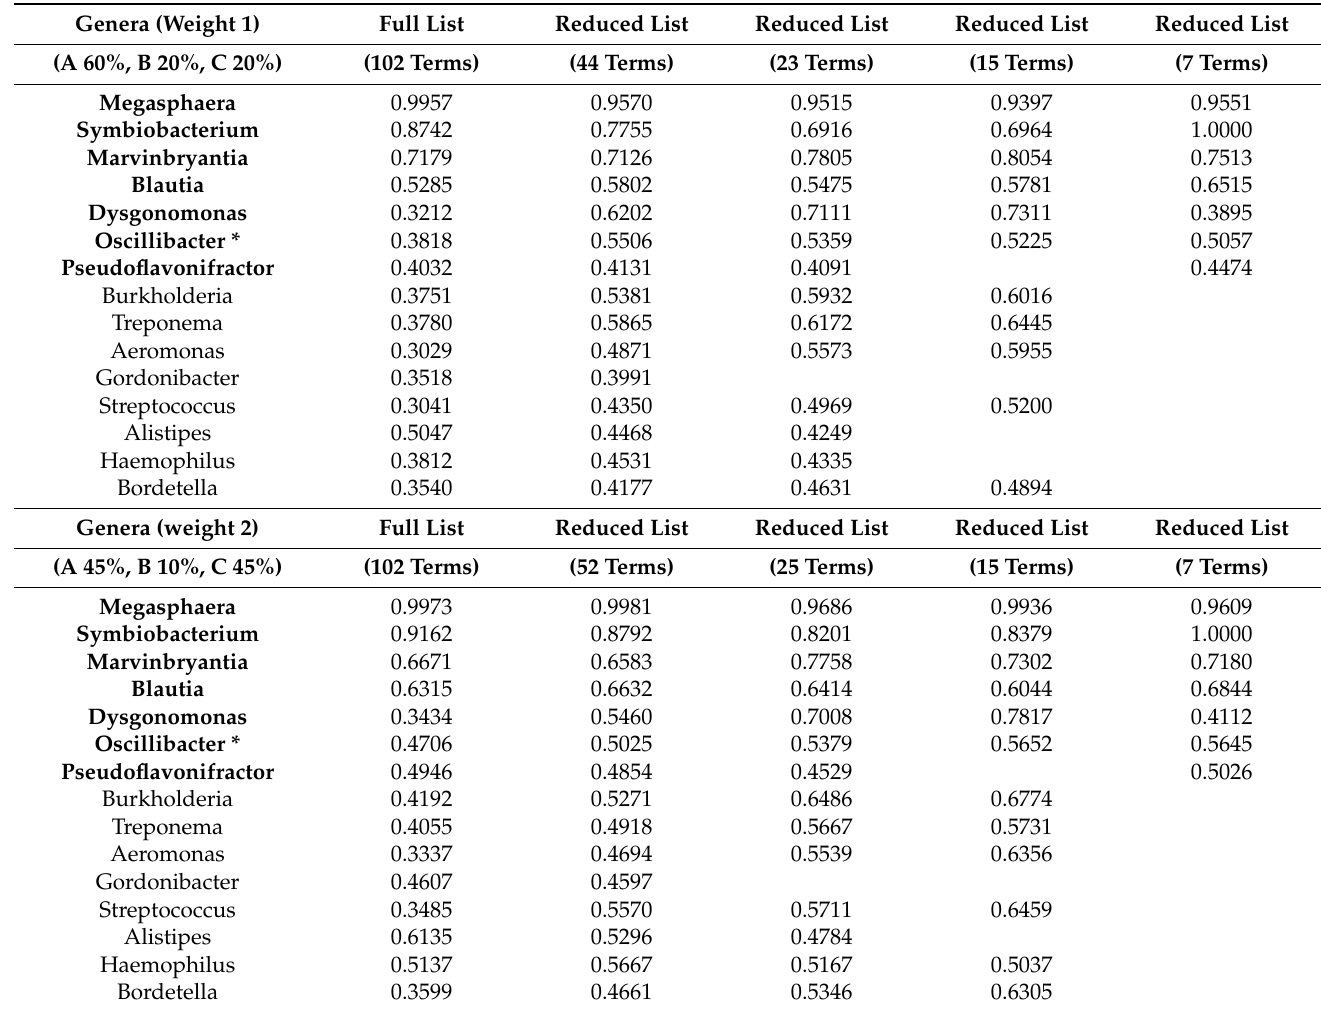
Table 3. Selection of genera predictor variables using the Monte Carlo approach.